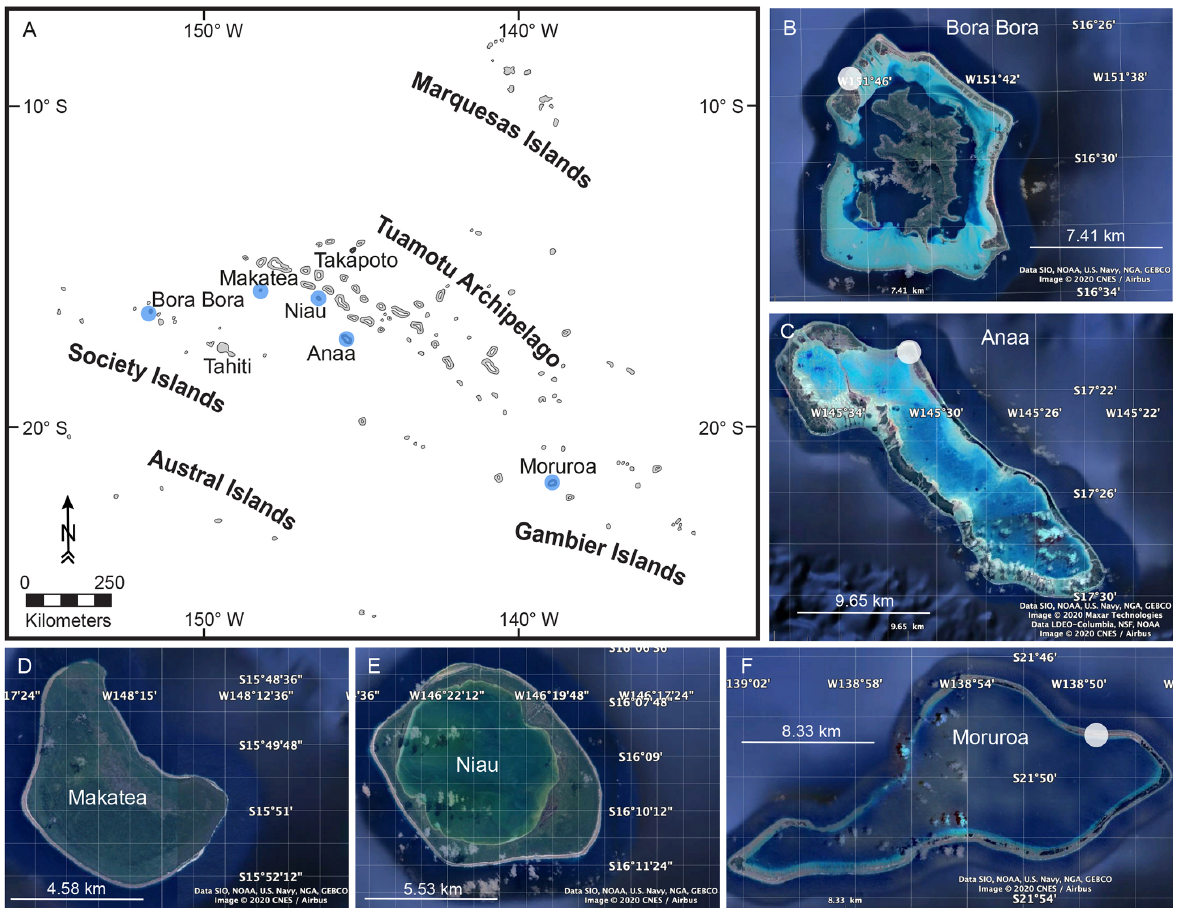
Figure 2. Map showing islands in French Polynesia considered in this article (blue dots). Study sites are indicated by white circles. © Google Earth 2020 (b–f)